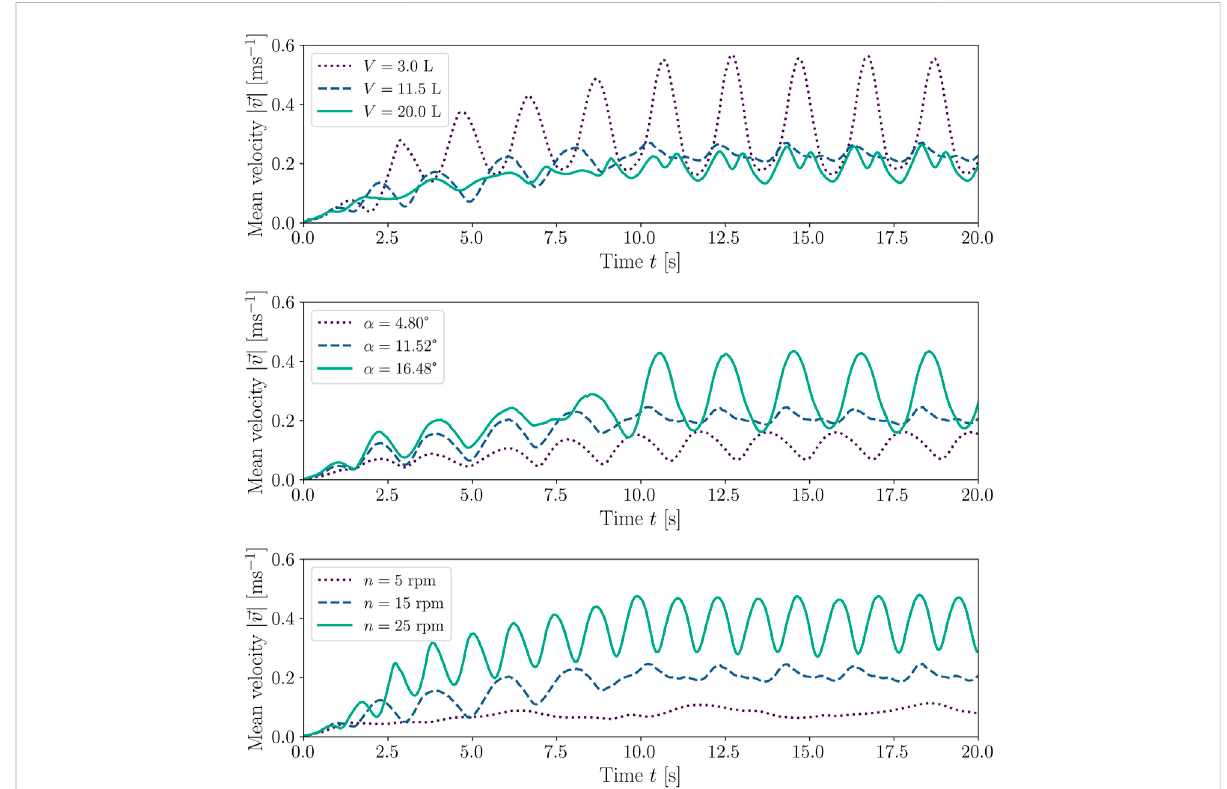
FIGURE 7 Comparison of the mean velocity magnitudes with different operating conditions. The standard con fi guration of the CELL-tainer was used for the representation. The upper fi gure shows three CFD simulations with different volumes, where the rocking rate was kept constant at 15 rpm and therockinganglewaskeptconstantat11.52 ° .Inthemiddle fi gure,theeffectofdifferentrockingangleswasinvestigatedatconstantworkingvolume (11.5 L) and rocking rate (15 rpm). In the lower fi gure, three different rocking rates at a rocking angle of 11.52 ° and 11.5 L were